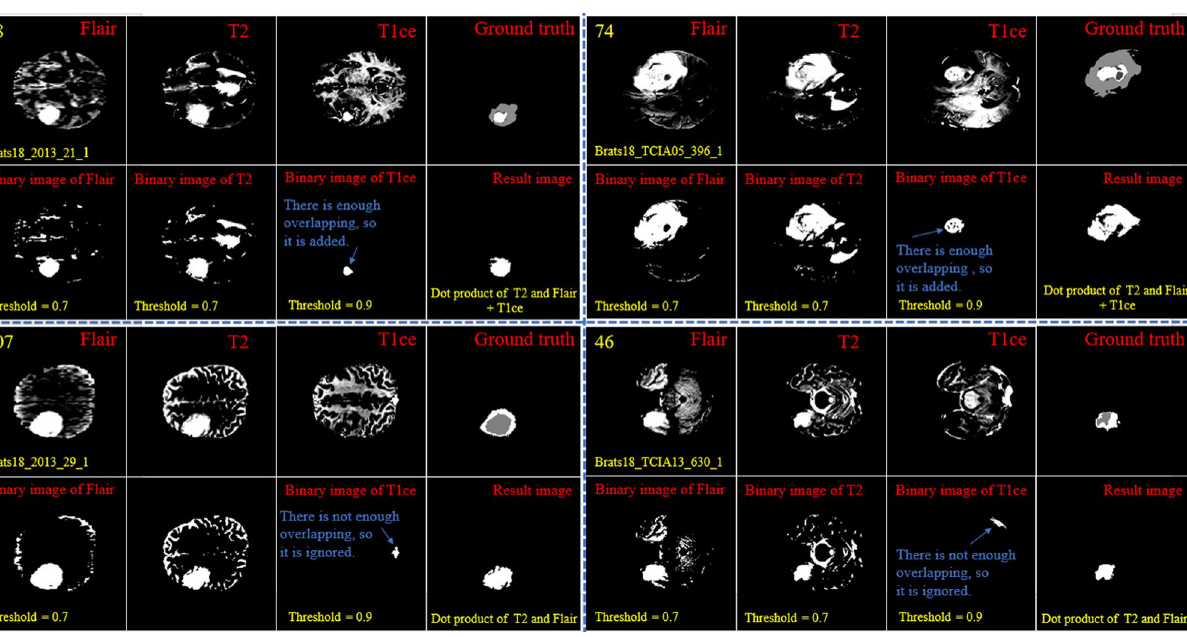
Figure 5. Demonstration of the process of finding a part of the tumor in each slice. The yellow color in the top left corner and the bottom indicates the slice number and sample ID, respectively. Also, the conditions for selecting the object are shown in yellow color. The red color is chosen to identify the presented image. The detected object from T1ce is indicated by the blue